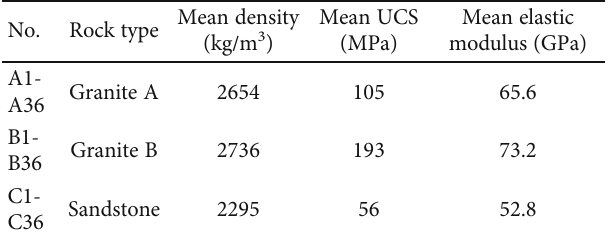
i , j ; (b) DRA curve. Table 1: Parameters of sandstone and granite samples in